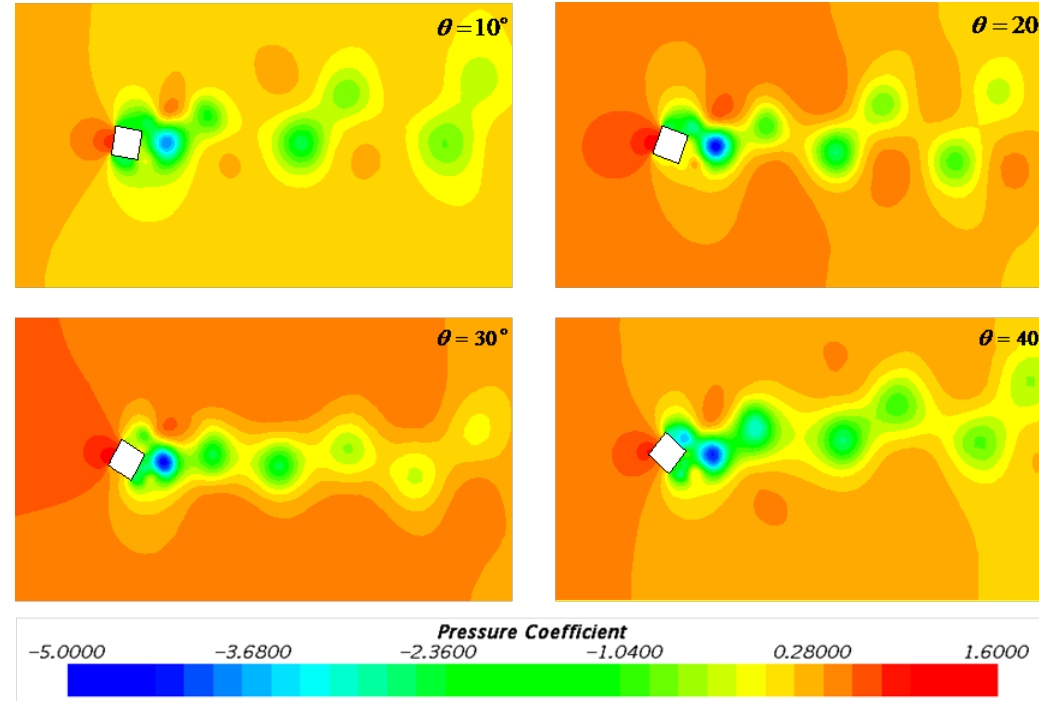
Figure 14. Pressure coefficient contours of the flow field around the square target at different incidence angles.